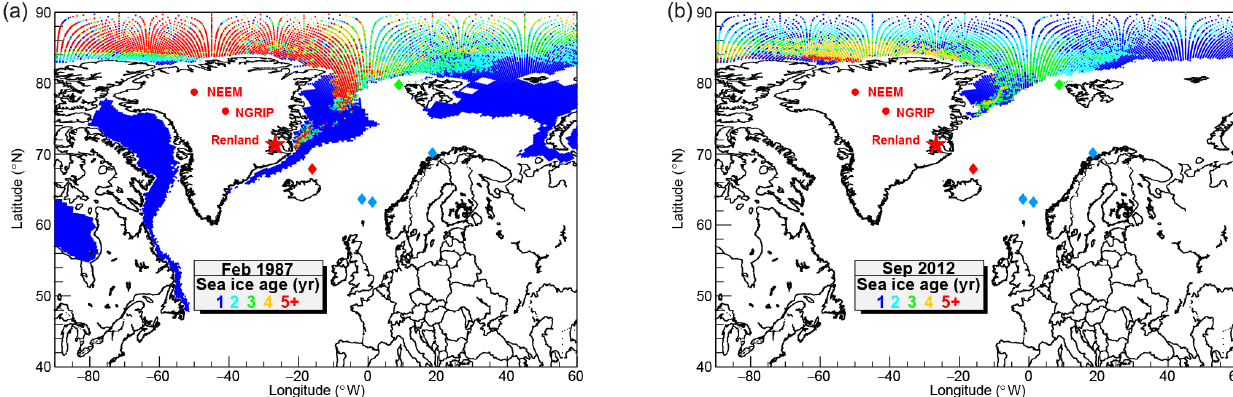
Figure 2. Map of modern Arctic sea ice age shown in representative extreme conditions: winter maximum (February 1987, a ) and summer minimum (September 2012, b ). The marine cores discussed in the text are indicated by coloured diamonds. See Fig. 1 for the marine core names and references. The sea ice age data are from NSIDC/NASA (v.3) (Tschudi et al.,